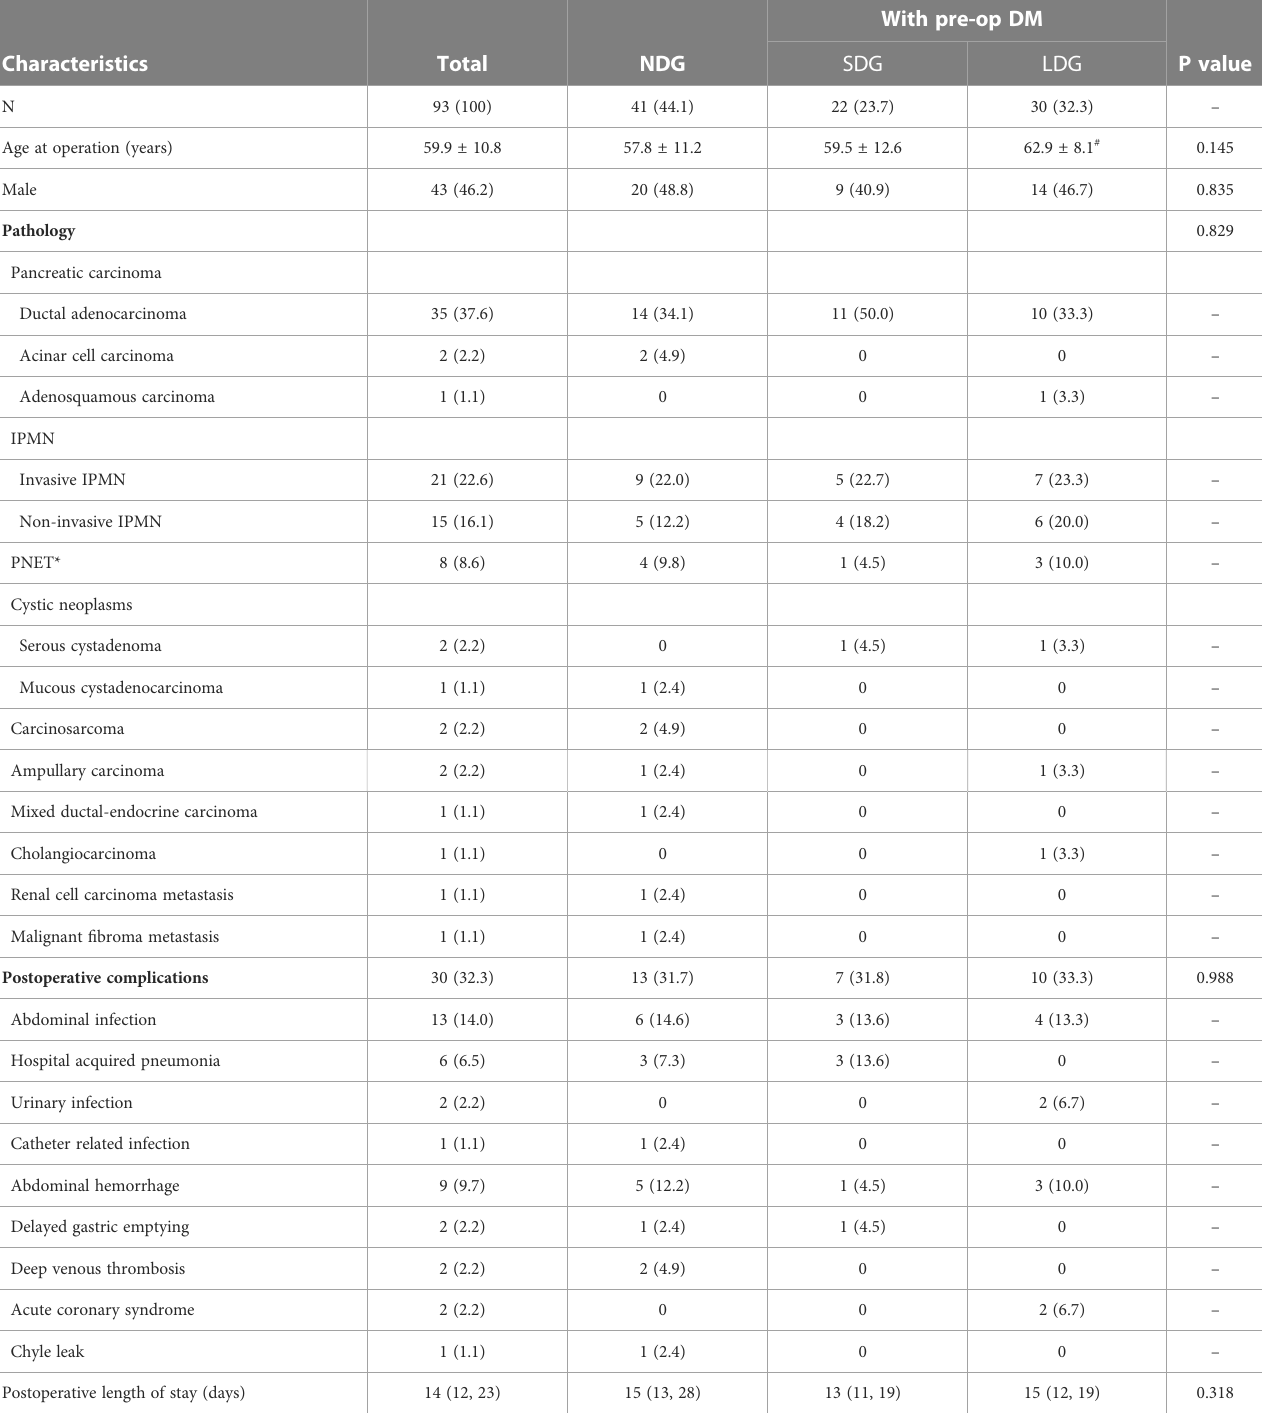
TABLE 1 Clinical and pathologic characteristics of 93 patients underwent total pancreatectomy.